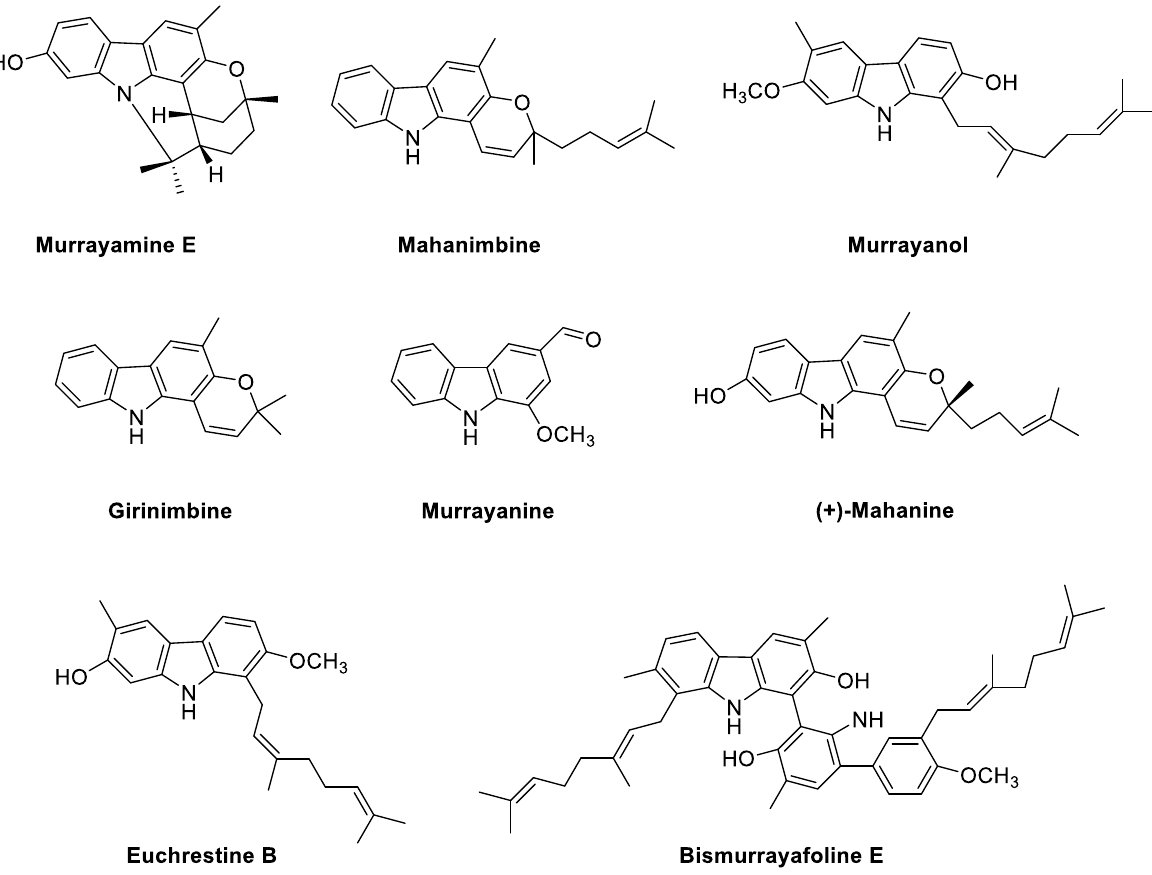
Figure 2. Potential neuroprotective phyto-carbazole alkaloids from Murraya koenigii .